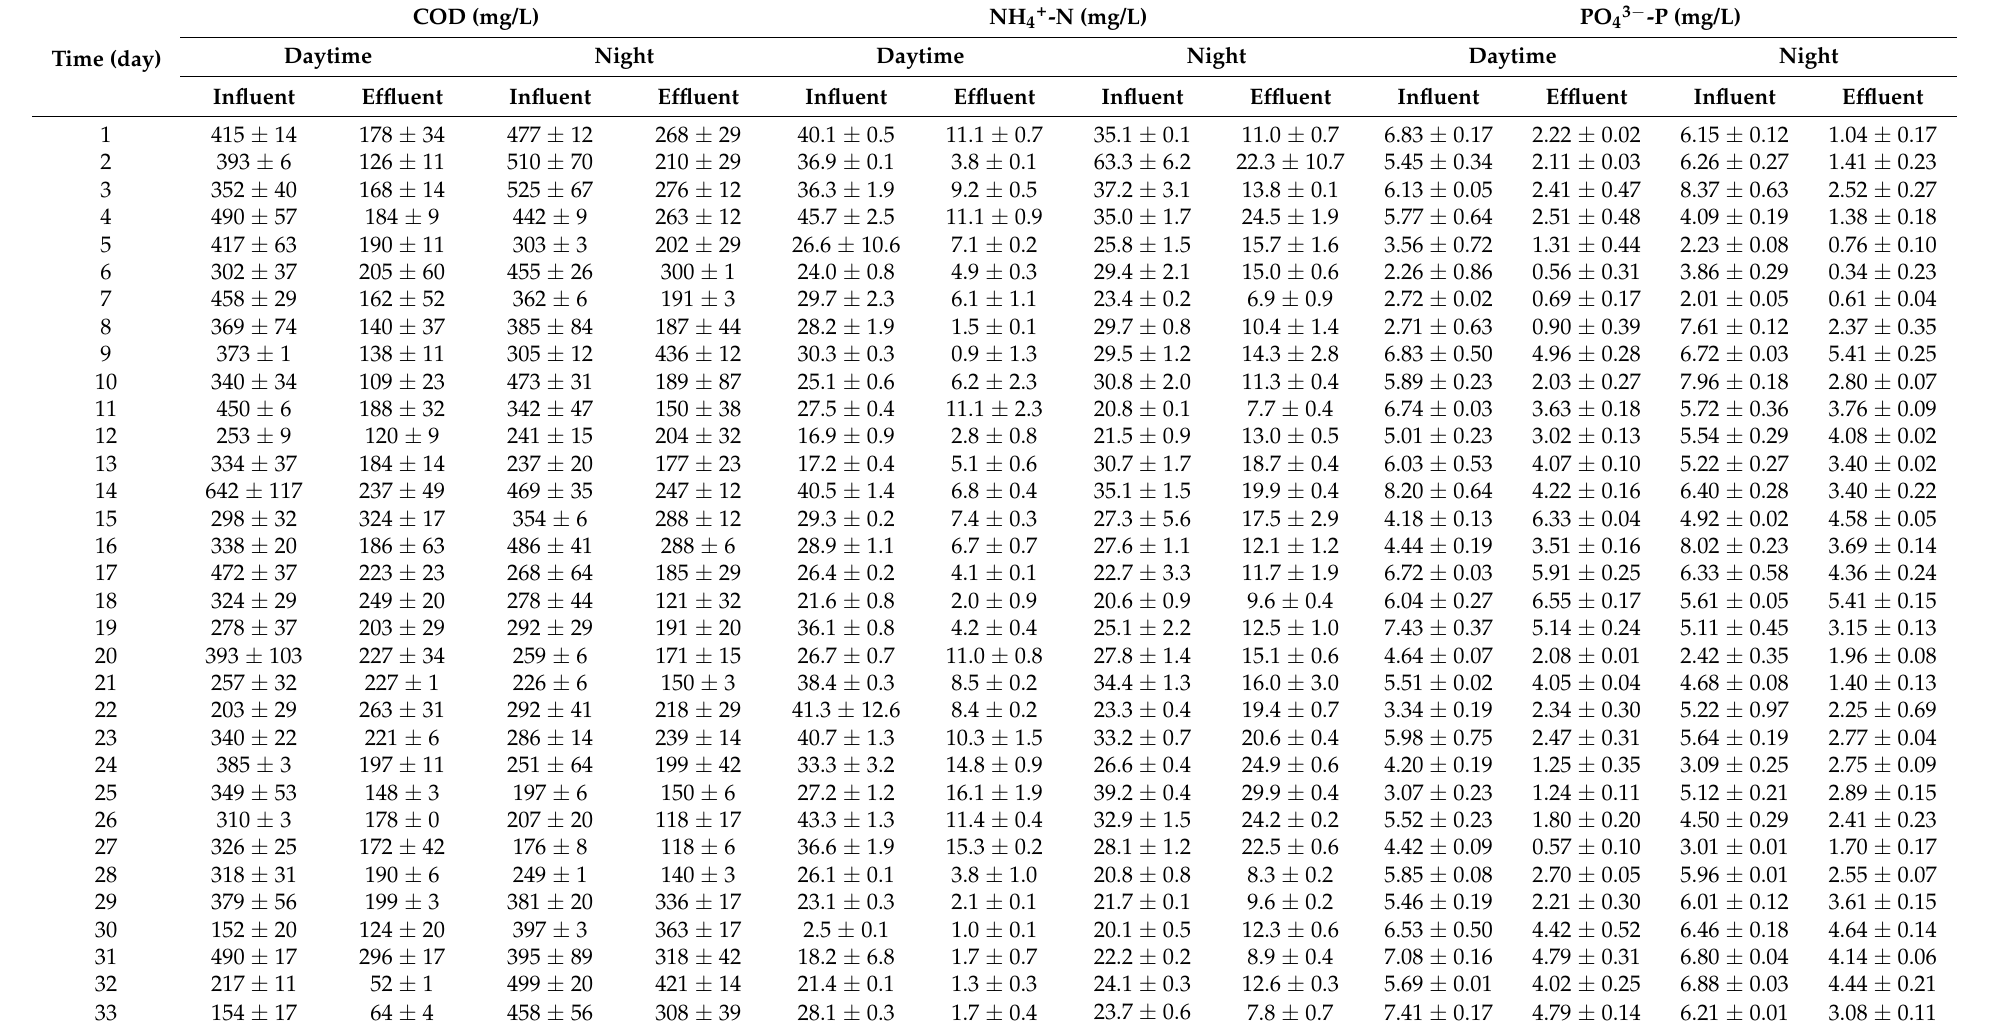
Table 1. The influent and effluent values in terms of Chemical oxygen demand (COD), NH 4+ -N and PO 43 −